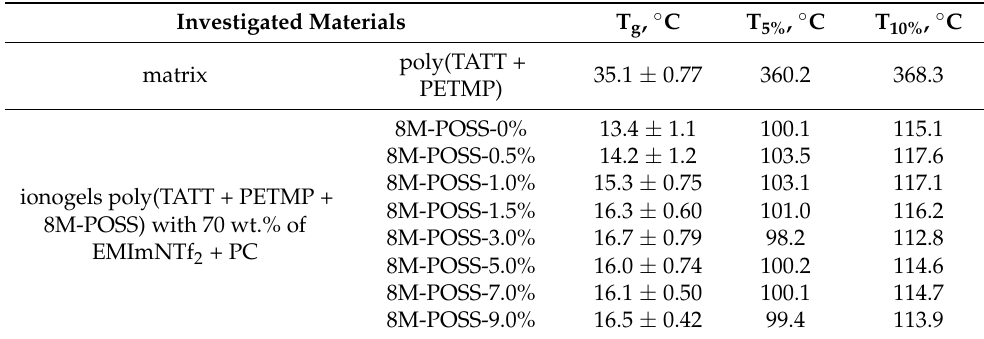
Table 3. Thermal properties of synthesized materials.